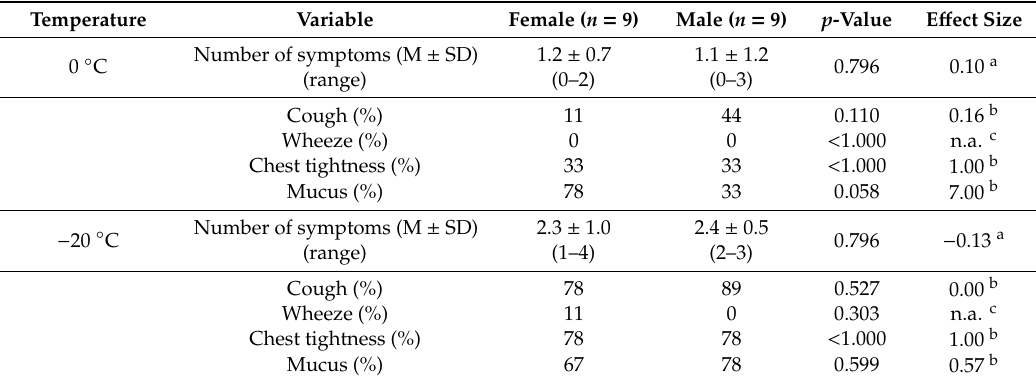
Table 2. Respiratory symptoms post-trial at 0 ◦ C and − 20 ◦ C in female and male